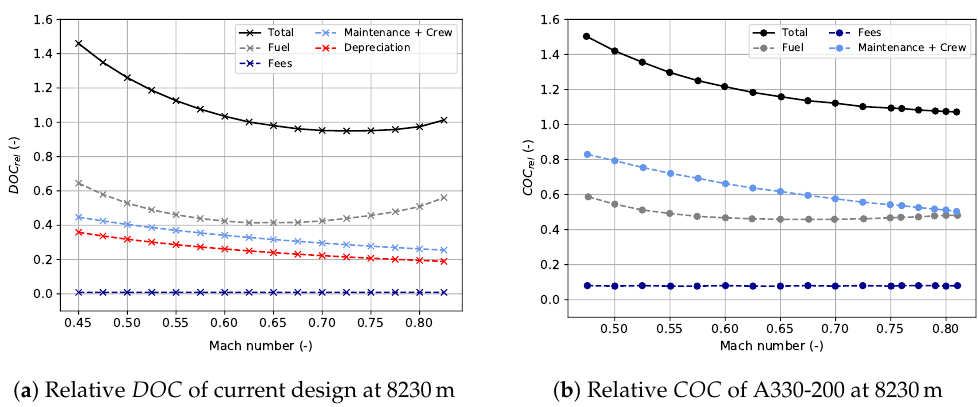
Figure 13. DOC / COC variation with Mach number relative to the A330-200 operating at Mach 0.82 and 10,973 m (A330-200 data from